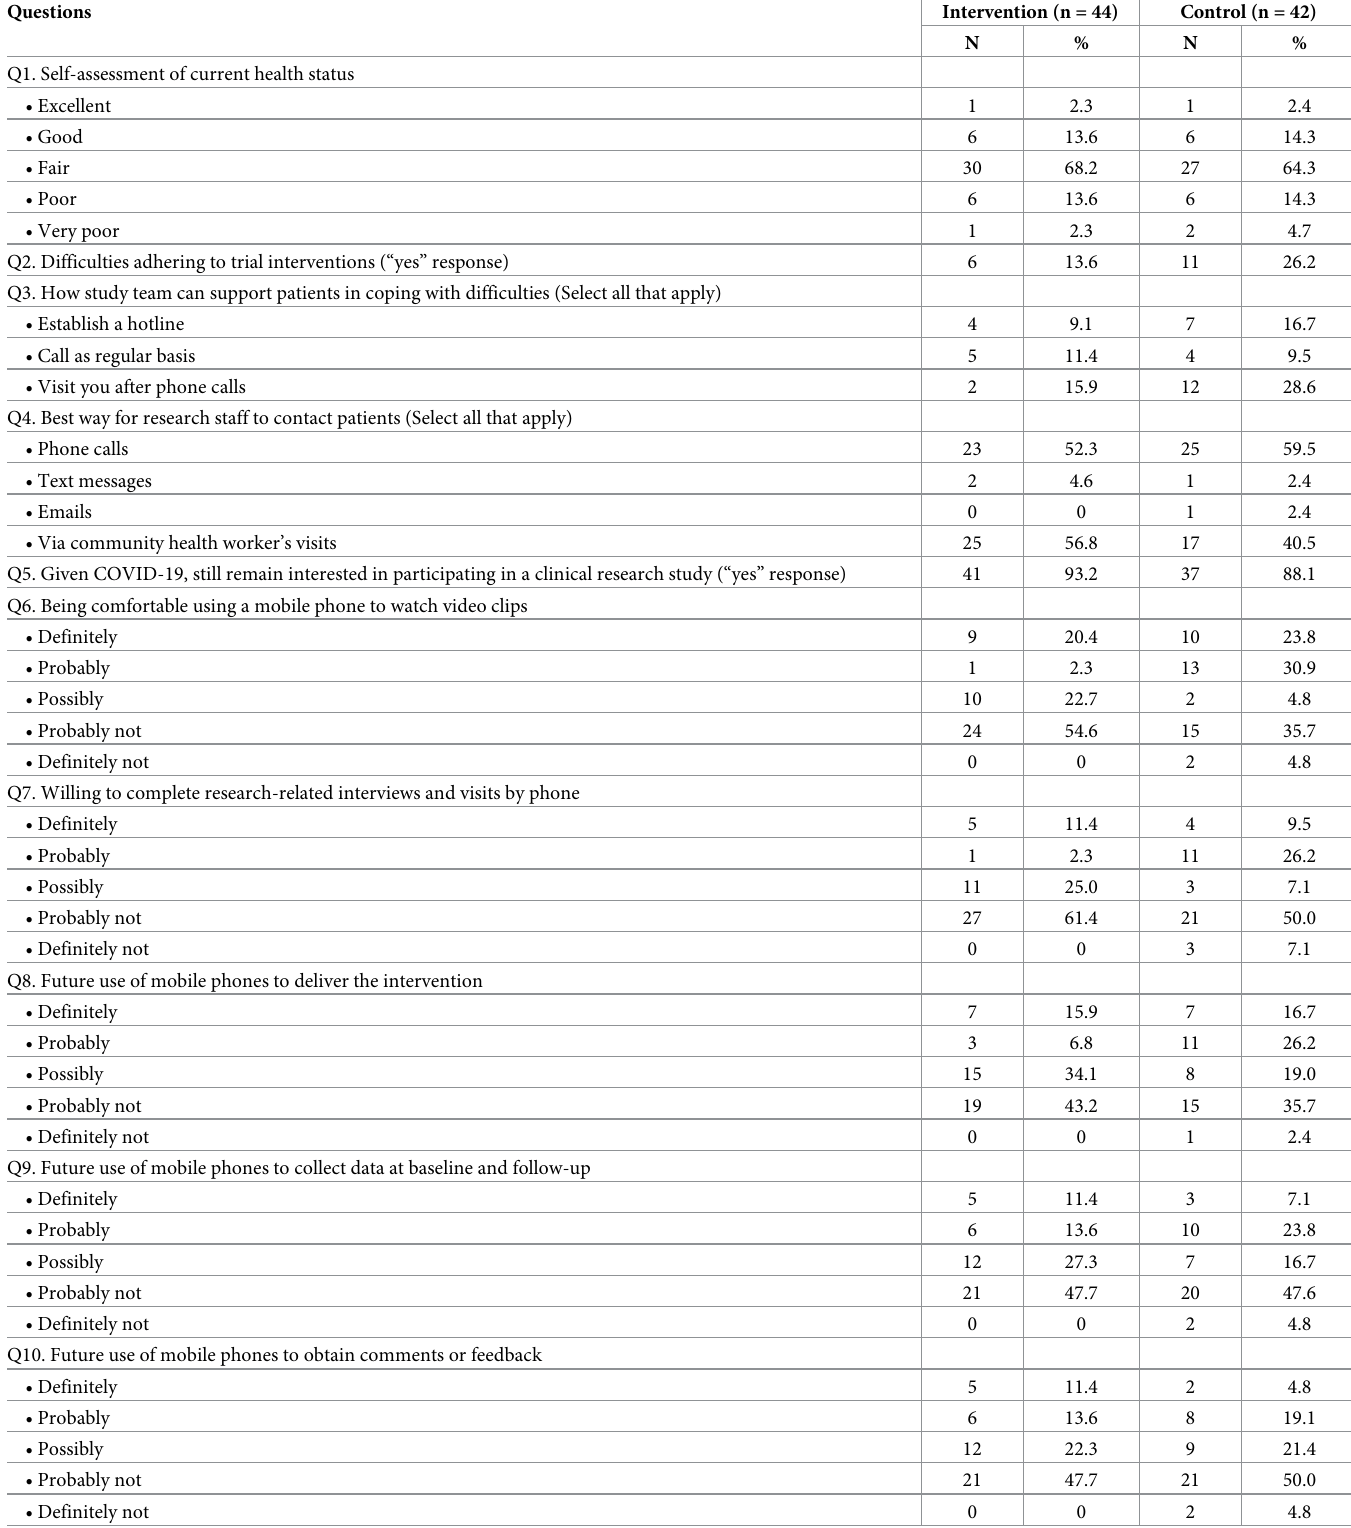
Table 2. COVID-19 impact on patients participating in an ongoing clinical